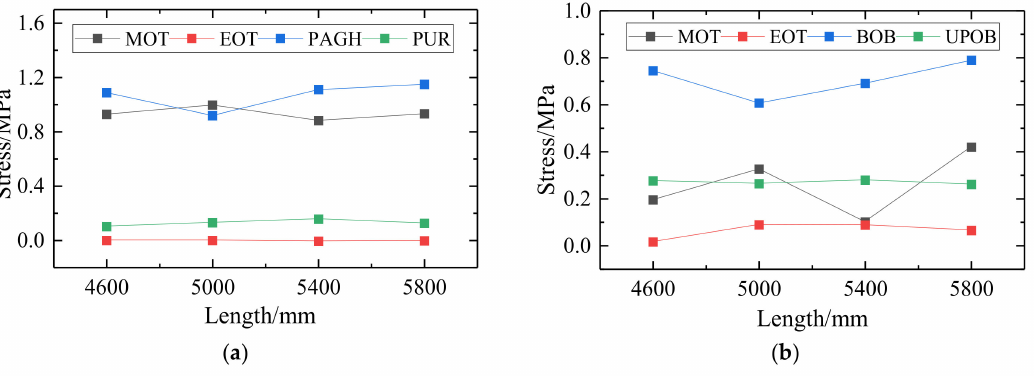
Figure 13. Maximum stress change curve of track structure under different length conditions: ( a ) Track slab; ( b ) Adjustment